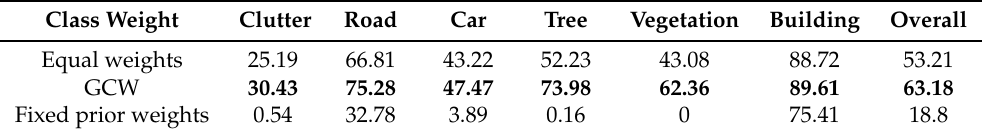
Table 3. The IoU (%) of each class with different class weights on POT →